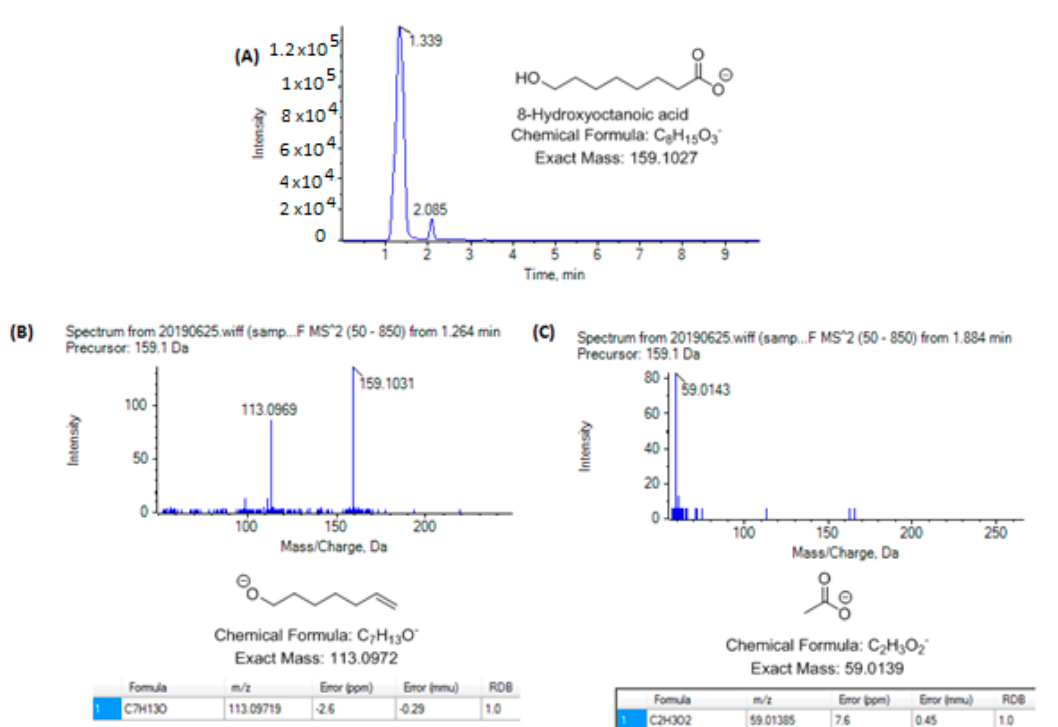
Figure 4. ( A ) EIC corresponding to exact mass of deprotonated hydroxyoctanoic acid; ( B ) MS / MS spectrum of the ion corresponding to peak eluted at 1.34 min; ( C ) MS / MS spectrum of the ion corresponding to peak eluted at 2.09 min.